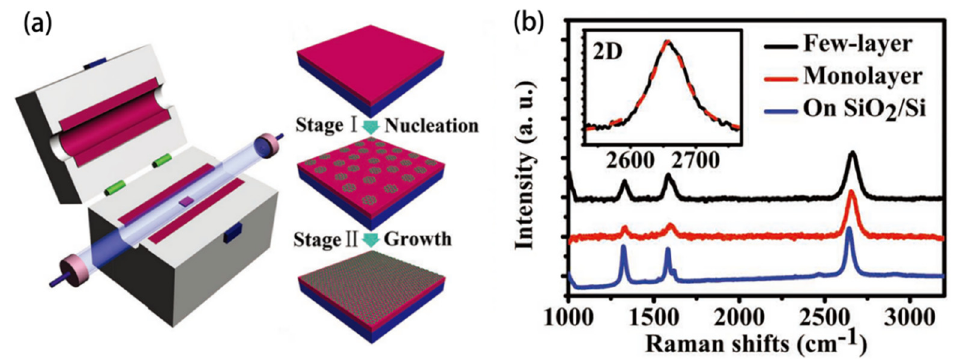
Figure 2. Two-step growth. ( a ) Apparatus and growth mechanism of graphene grown in a two-step method; ( b ) Raman characterization of in situ graphene [33].